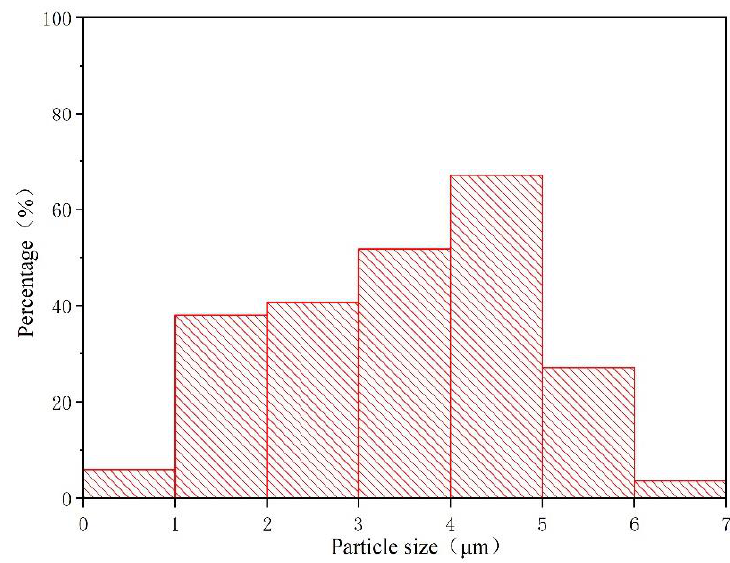
Figure 2. Particle size distribution of waterborne acrylic resin microcapsules.